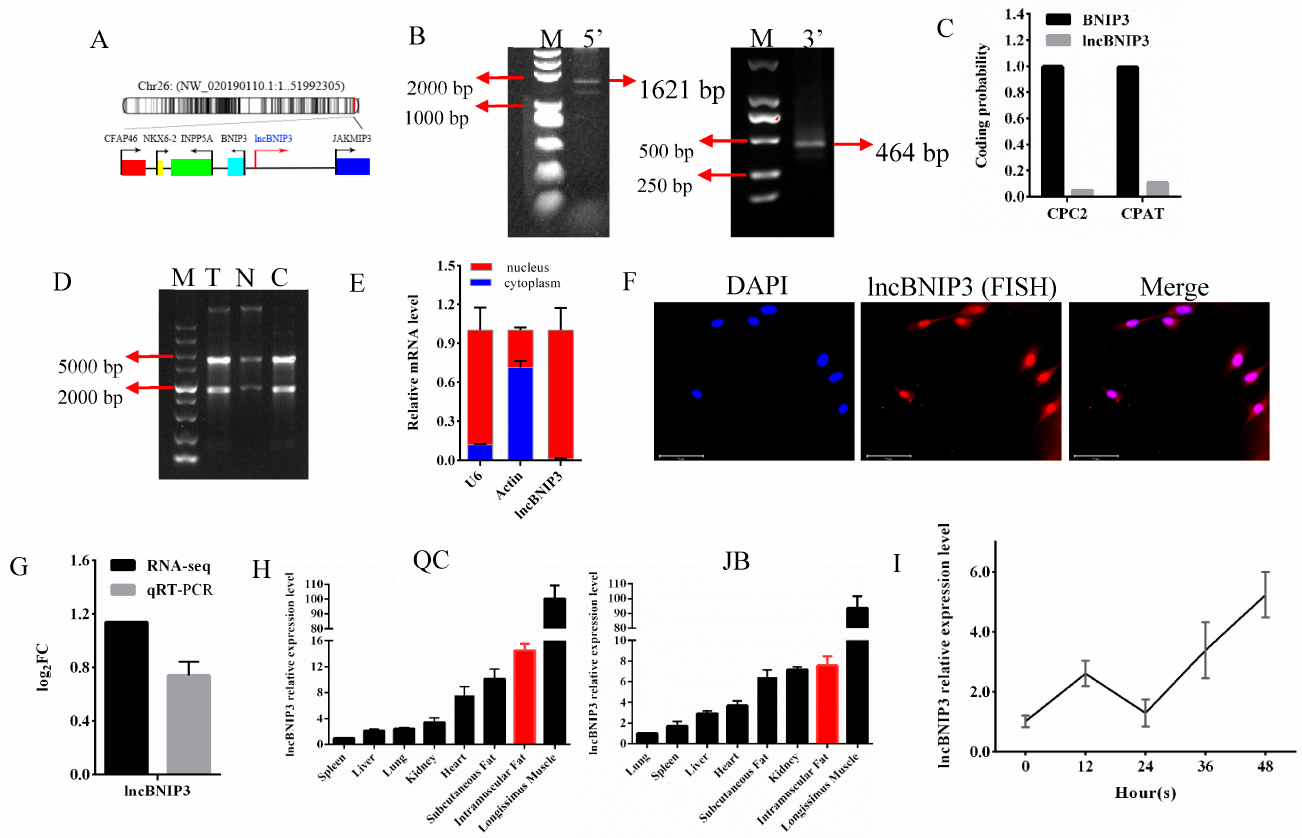
Figure 1. The biological characteristics and expression profile analysis of lncBNIP3 . ( A ) Location of lncBNIP3 on chromosomes; ( B ) Gel electrophoresis results of RACE product (M for the marker, a fragment size of 5 ′ RACE gel marker, from top to bottom, was 5000 bp, 3000 bp, 2000 bp, 1000 bp, 750 bp, 500 bp, 250 bp, 100 bp; a fragment size of 3 ′ RACE gel marker, from top to bottom, was 2000 bp, 1000 bp, 750 bp, 500 bp, 250 bp, 100 bp); ( C ) Prediction results of lncBNIP3 encoding potential in CPC2 and CPAT, and BNIP3 mRNA was a positive control; ( D ) Gel electrophoresis of cytoplasmic and nuclear RNA separation (M for marker, T for total RNA, N for nuclear RNA, C for cytoplasmic RNA); ( E ) The expression of lncBNIP3 in nucleus and cytoplasm (U6 and β -actin were controls); ( F ) FISH results of lncBNIP3, scale bar: 200 μ m; ( G ) The expression levels of lncBNIP3 in QC cattle and